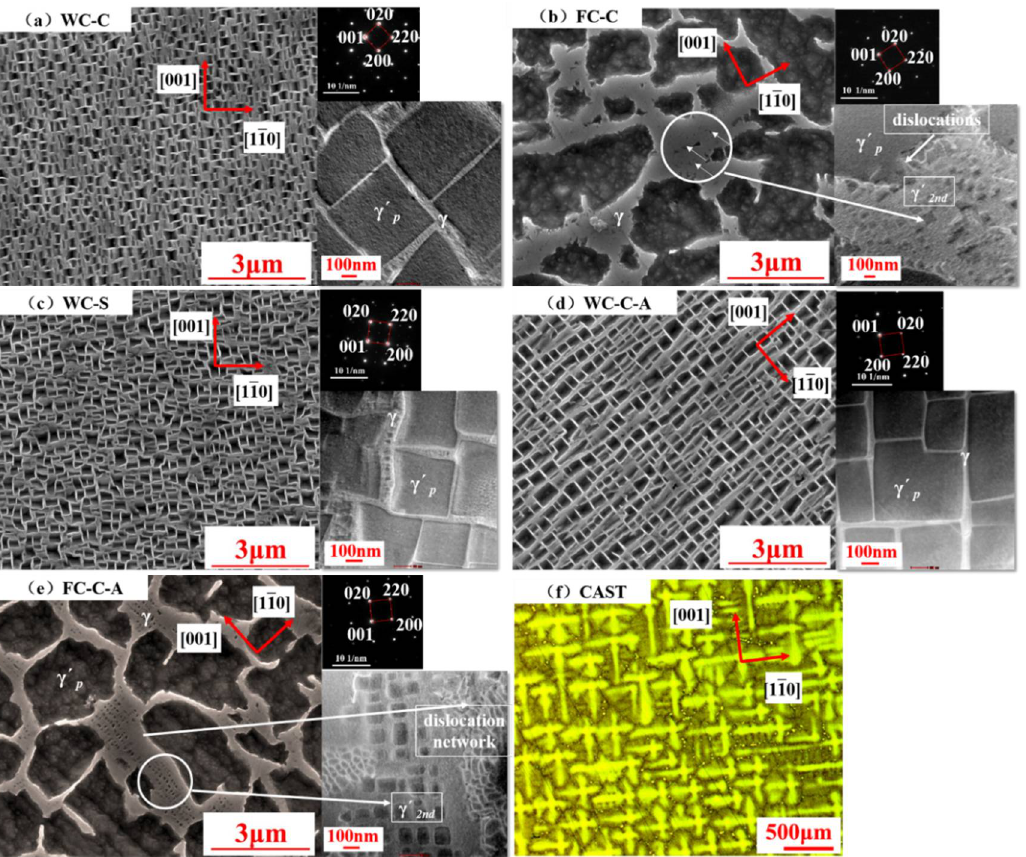
Figure 5. The micrographs for different cooling condition samples. The left part of each case is the back-scattered electron SEM image and the micrograph in the right part of each case is the scanning transmission electron microscopy (STEM) image accompanied by its diffraction spots. ( γ ′ p is the abbreviation for the primary γ ′ phase; γ ′ 2nd is the abbreviation for the secondary γ ′-particles). The SEM images, STEM images and the diffraction spots of WC-C sample ( a ), FC-C sample ( b ), WC-S sample ( c ), WC-C-A sample ( d ), and FC-C-A sample ( e ). ( f ) is the image of the as-cast structure.